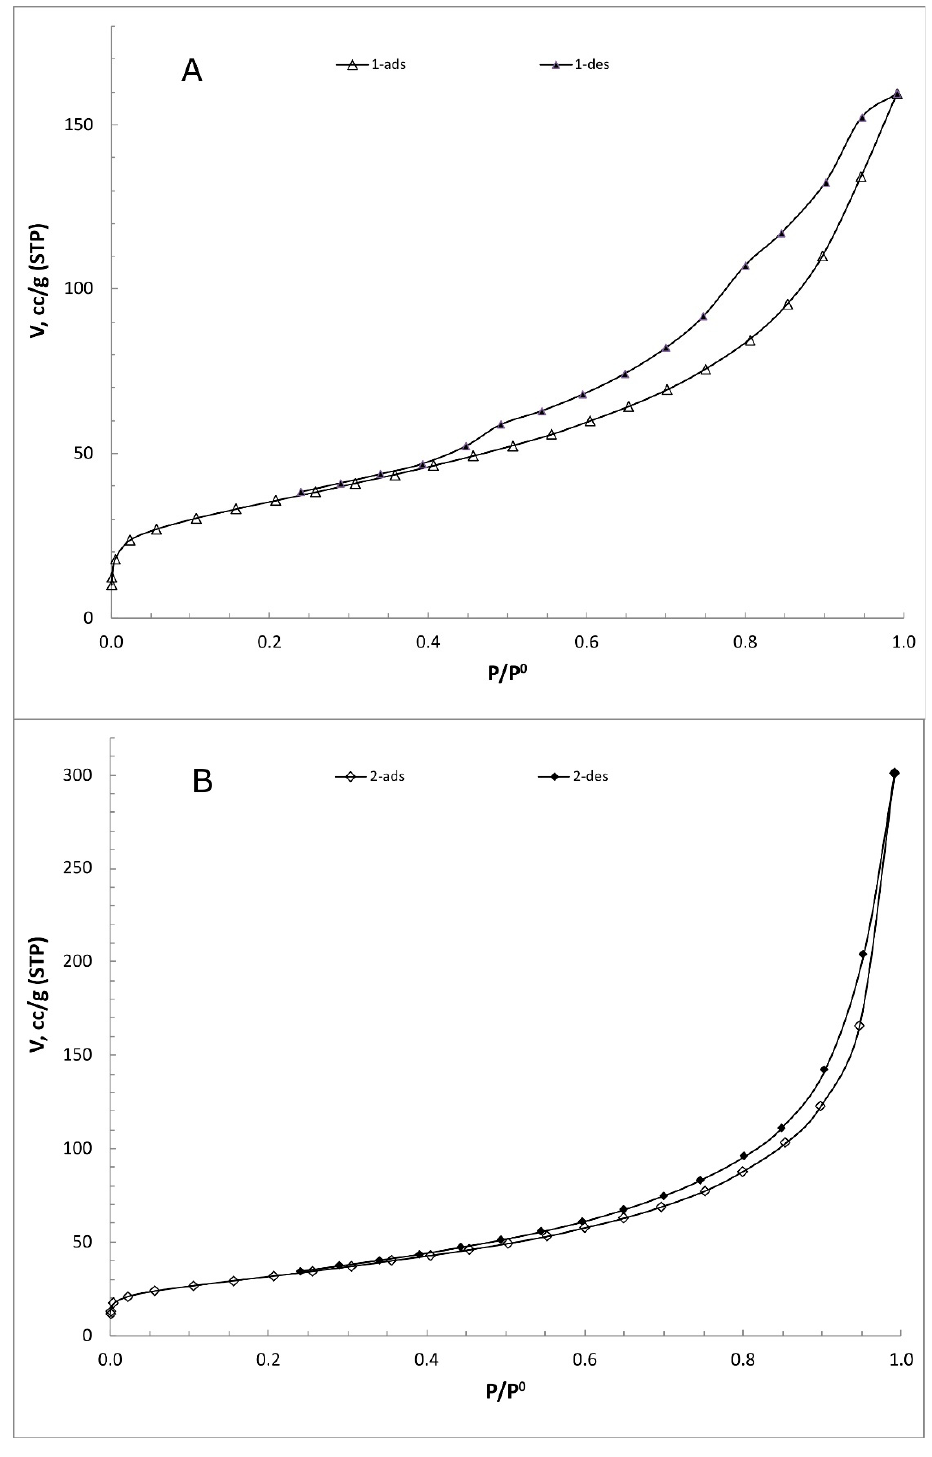
Figure 3. Nitrogen adsorption-desorption isotherms of ( A ) bare LDH and ( B ) LDH/GQDs compo-